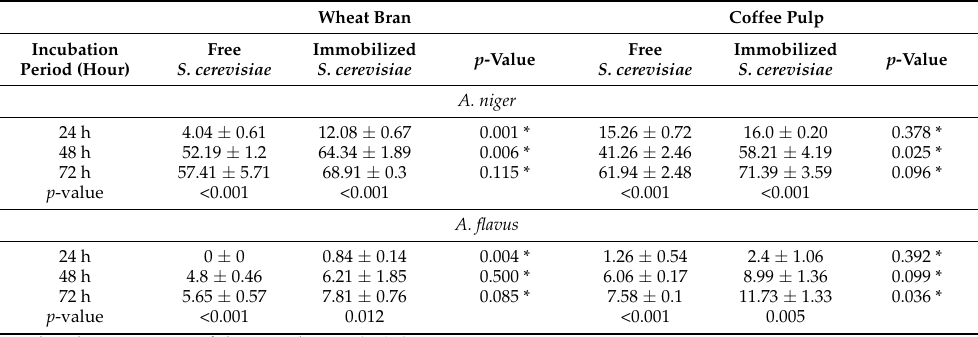
Table 6. The ethanol concentration (mg/mL) is produced by fermenting the products of enzymatic hydrolysis of wheat bran and coffee pulp by A. niger and A. flavus using S. cerevisiae as free or Na-alginate immobilized